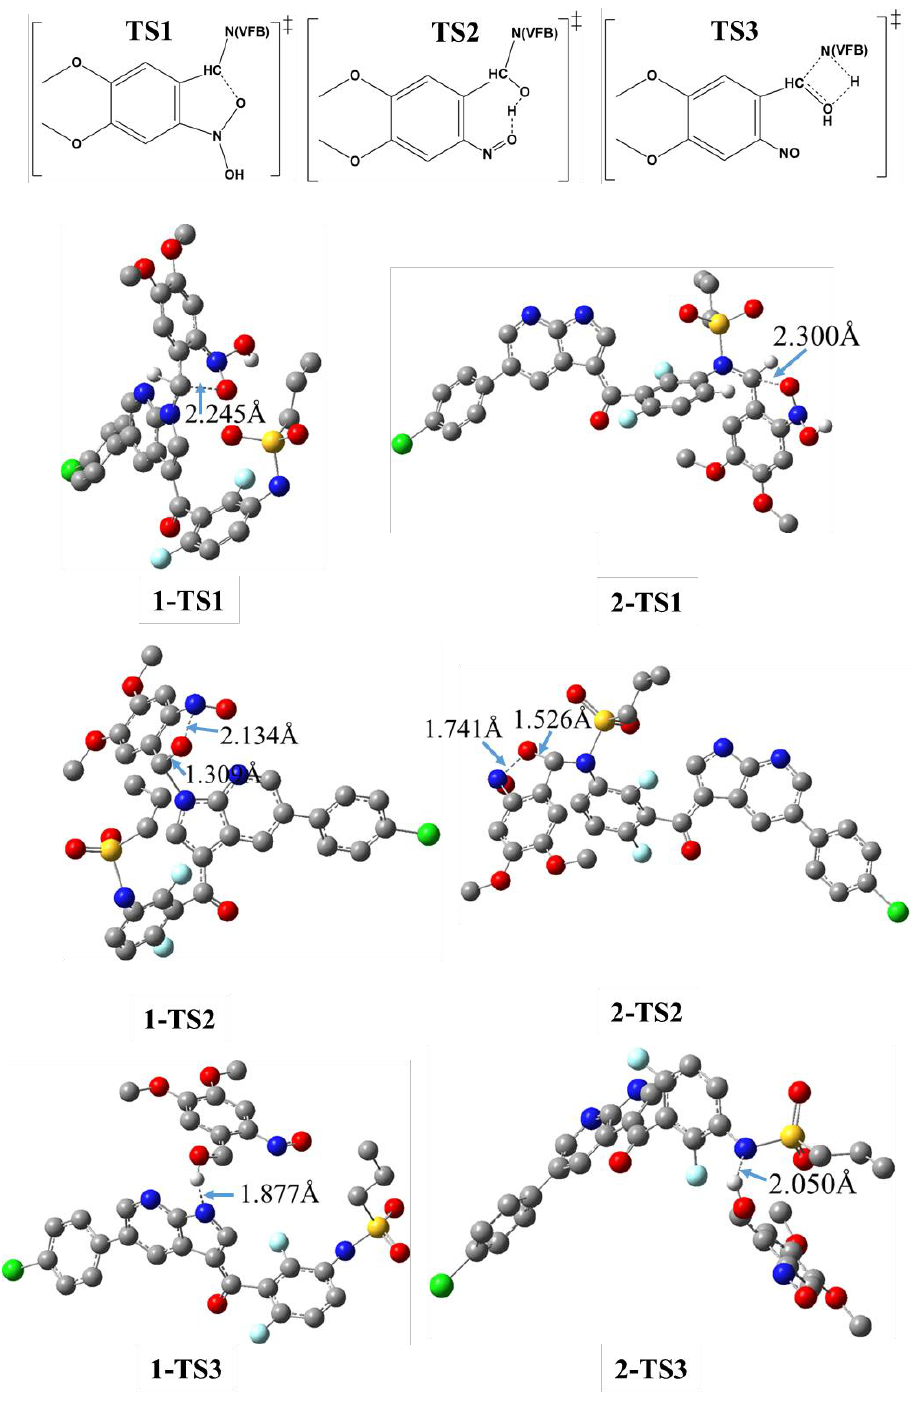
Figure 4. DFT/B3LYP/6-31+G(d))-optimized geometry of the transition state (TS) of the photouncaging of 1 and 2; uninvolved hydrogen atoms are omitted for clarity; the given numbers correspond to the bond length of selected key bonds as indicated by arrows.